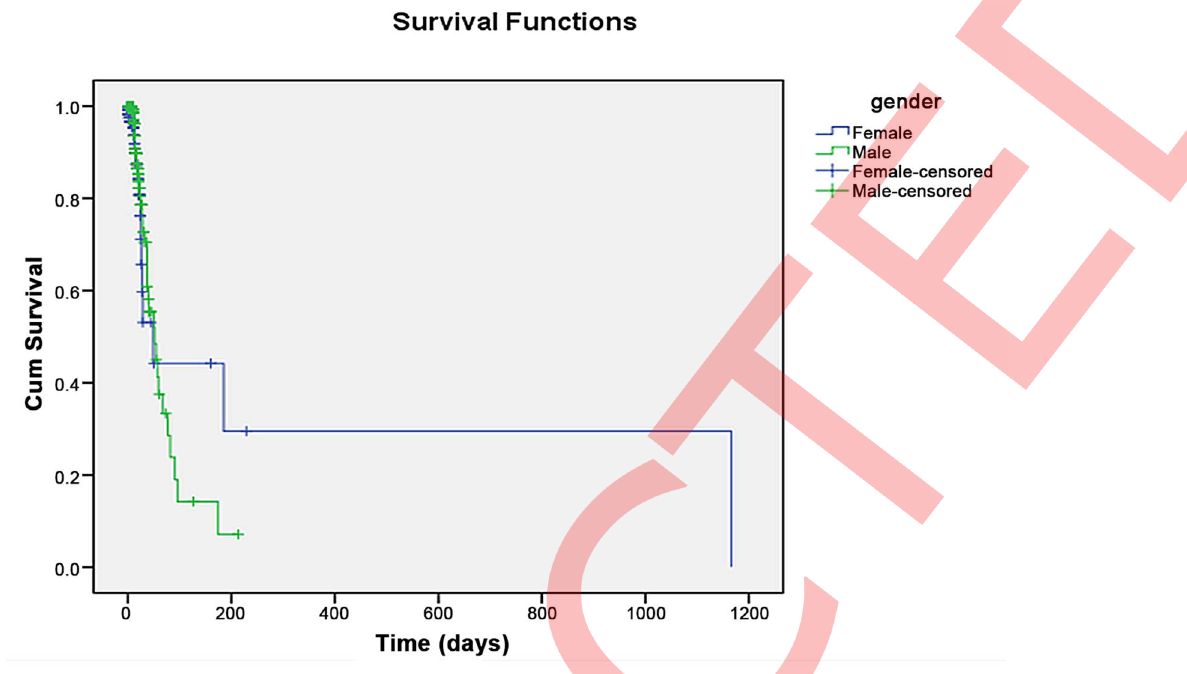
Figure 2. Plot of the Kaplan Meier Survival function curve for the data.